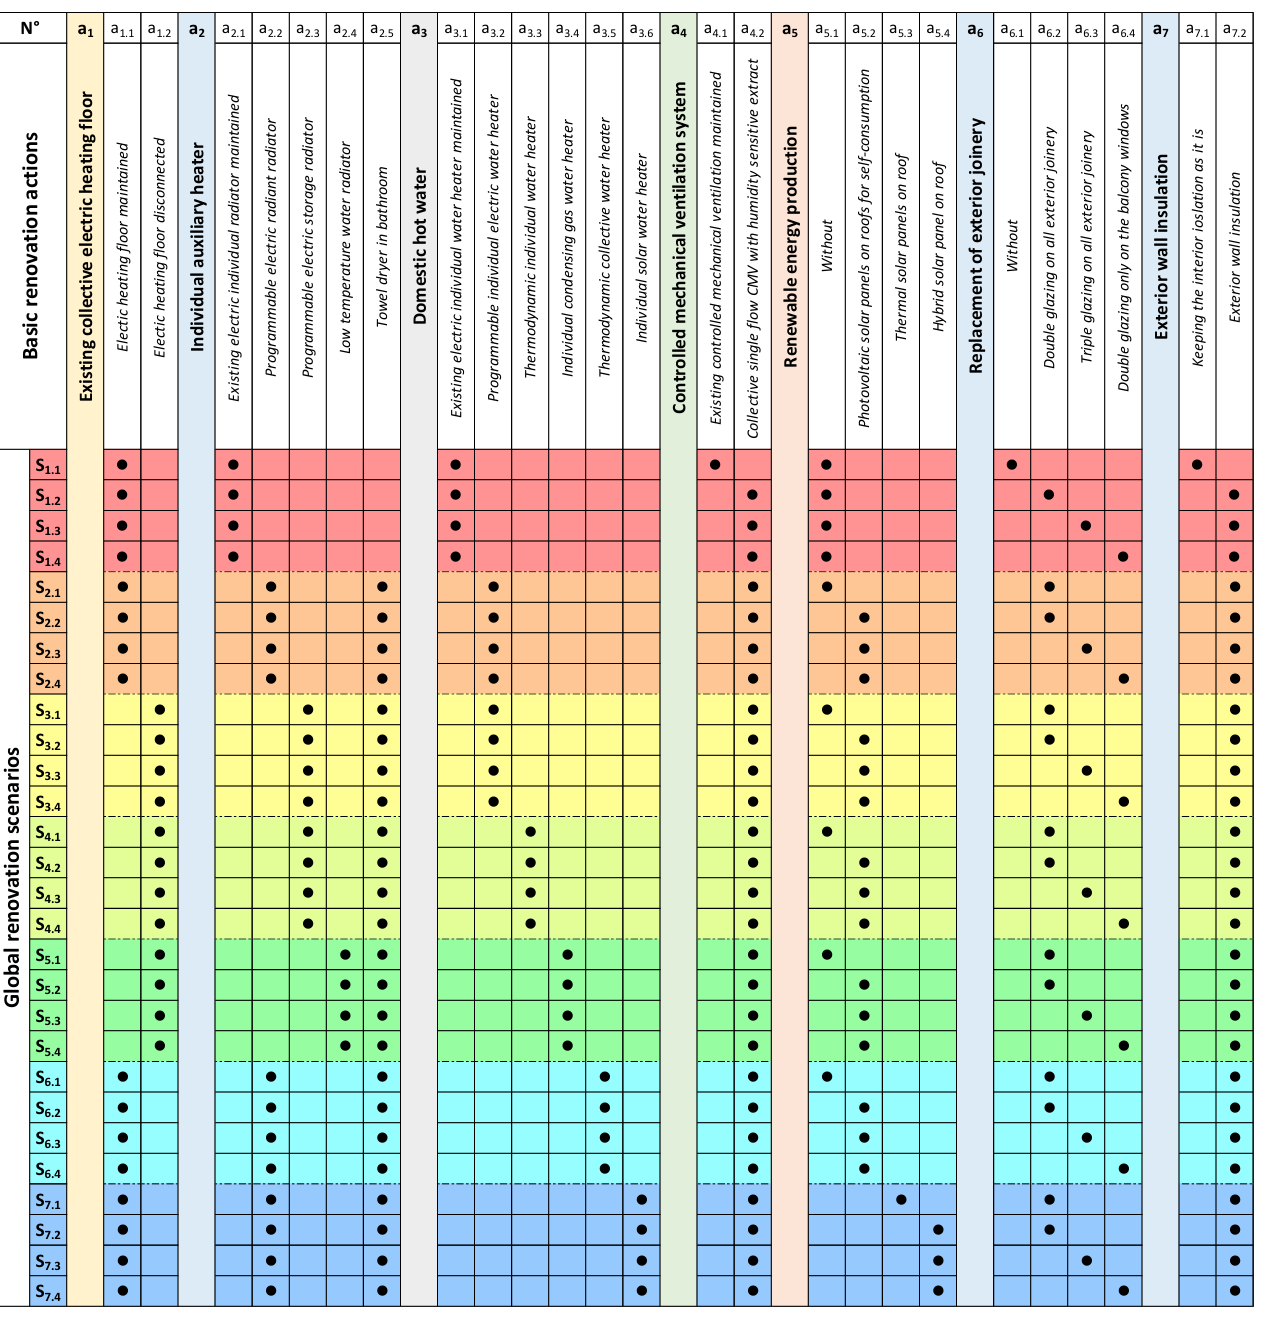
Figure 6. Global retrofit scenarios from individual exclusive actions. When constructing these seven categories of global renovation scenarios from indi- vidual elementary actions, particular attention was paid to the homogeneity and con- sistency of the combinations. Particular attention was also given to the scenario 𝑆 1.1 which represents the initial state of the building without any modification of the envelope or technical systems. This scenario is a reference to compare the other ones and determine their impact on performances. It is important to note that all the global renovation scenar- ios constructed in this way have in common the installation of towel dryers in the bath- rooms to improve the thermal comfort of the dwellings in a simple and economic way, as well as the installation of thermal insulation from the outside, which is one of the first measure for reducing energy needs.